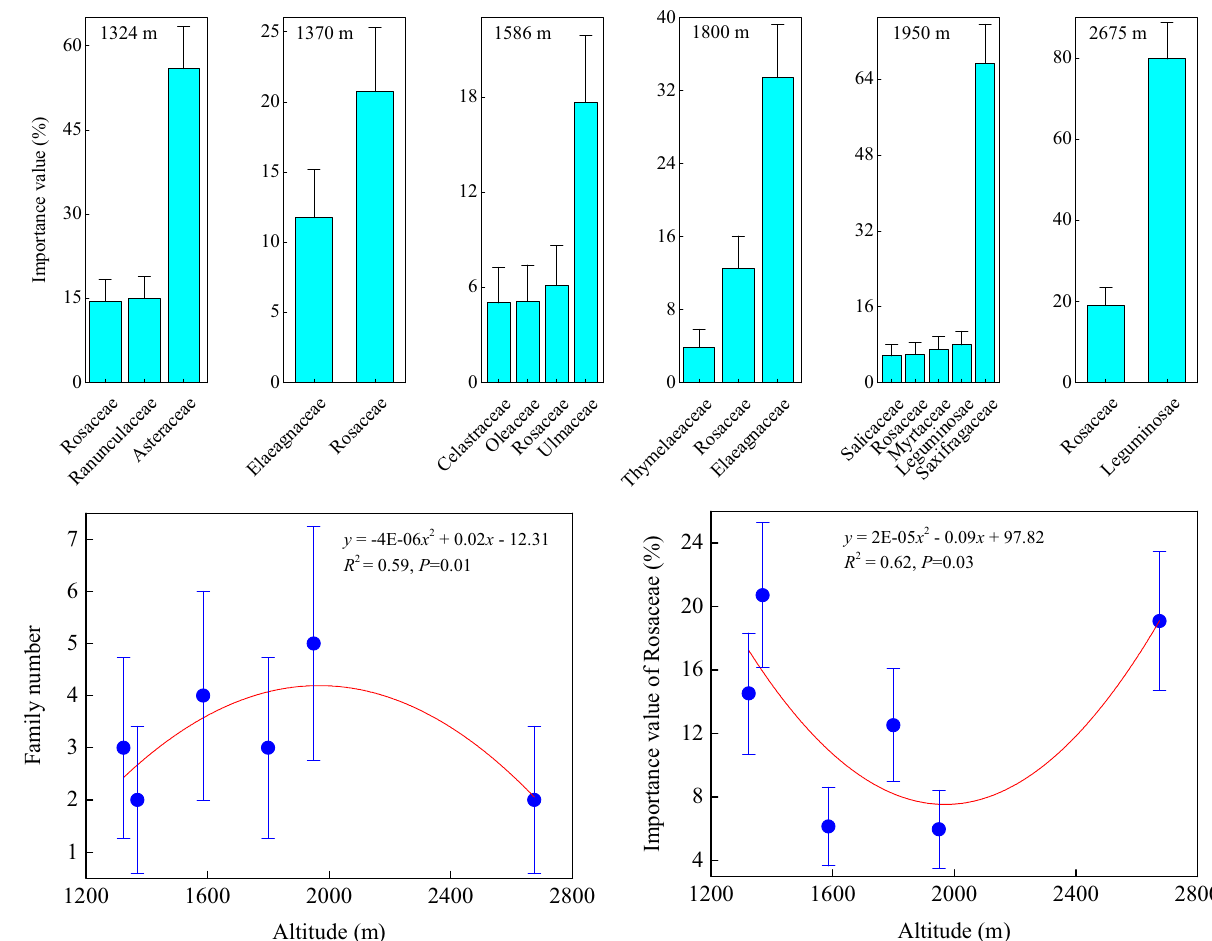
Figure 4. Distribution and variation of importance values and numbers of shrub families at different elevations. There were 6 elevations for the shrub community. At each elevation, the importance values of the shrub families were arranged in ascending order to obtain the dominant family. Data for each shrub family were averaged from 64 sub-quadrats at each elevation. Finally, regression analyses were carried out on relationships between the family number of the shrub community and the importance value of the dominant family (Rosaceae) along the altitudinal